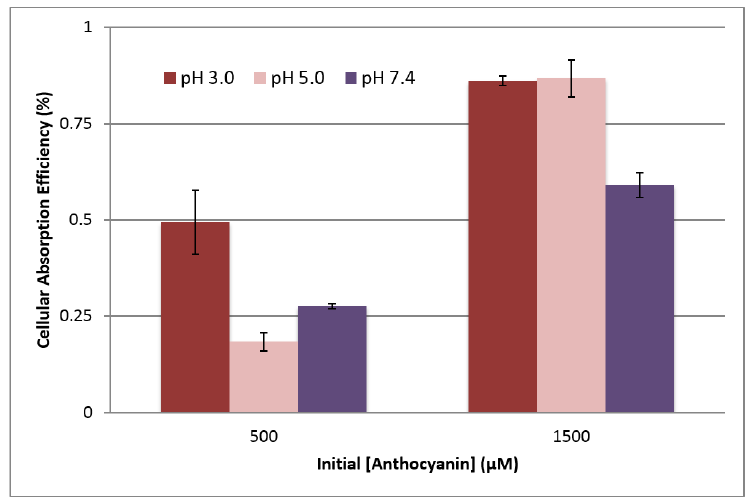
Figure 6. Effects of apical pH on the cellular anthocyanin uptake efficiency (%) of NCI-N87 cells after 3 h treatment at 37 °C and basolateral pH 7.4. Uptake efficiency was calculated as (Concentration extracted from cell layer/Initial treatment concentration) ×